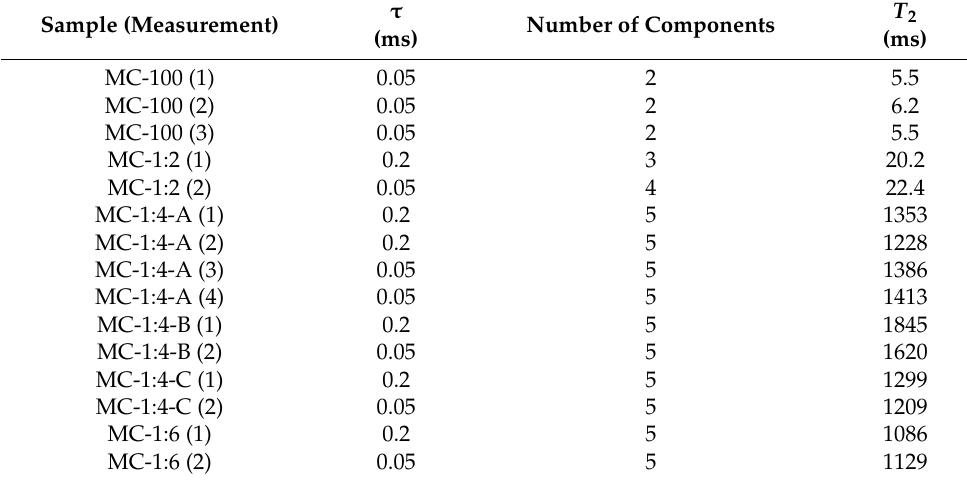
Table 4. Optimized number of components determined for the fitting of the magnetization decay and for corresponding weighed average of relaxation times. Measurements were repeated, and each experiment was given numbers put in